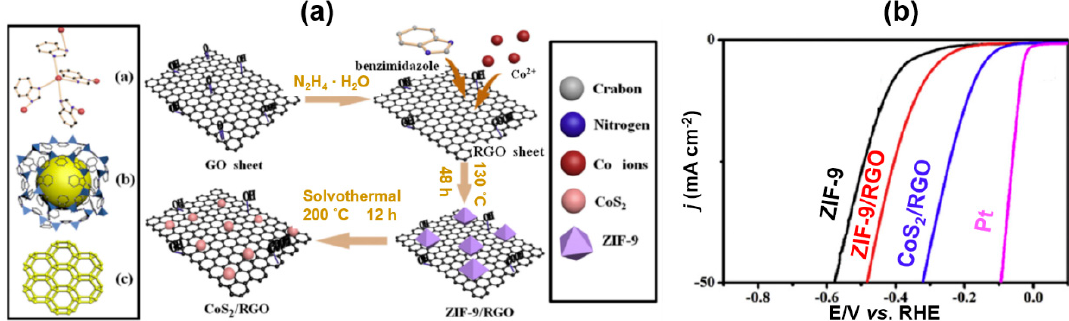
Figure 21. ( a ) Schematic illustration of the synthesis of CoS 2 /RGO; and ( b ) HER polarization curves (cathodic sweep) collected on different catalysts with mass loading of 0.285 mg cm − 2 in 0.5 M H 2 SO 4 acidic solution at a scan rate of 5 mV s − 1 at room temperature. Reproduced from [176], Copyright © Elsevier, 2017.